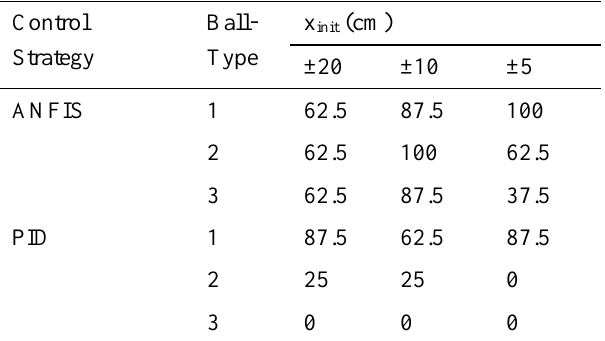
Comparison of success rate (%) Control Strategy